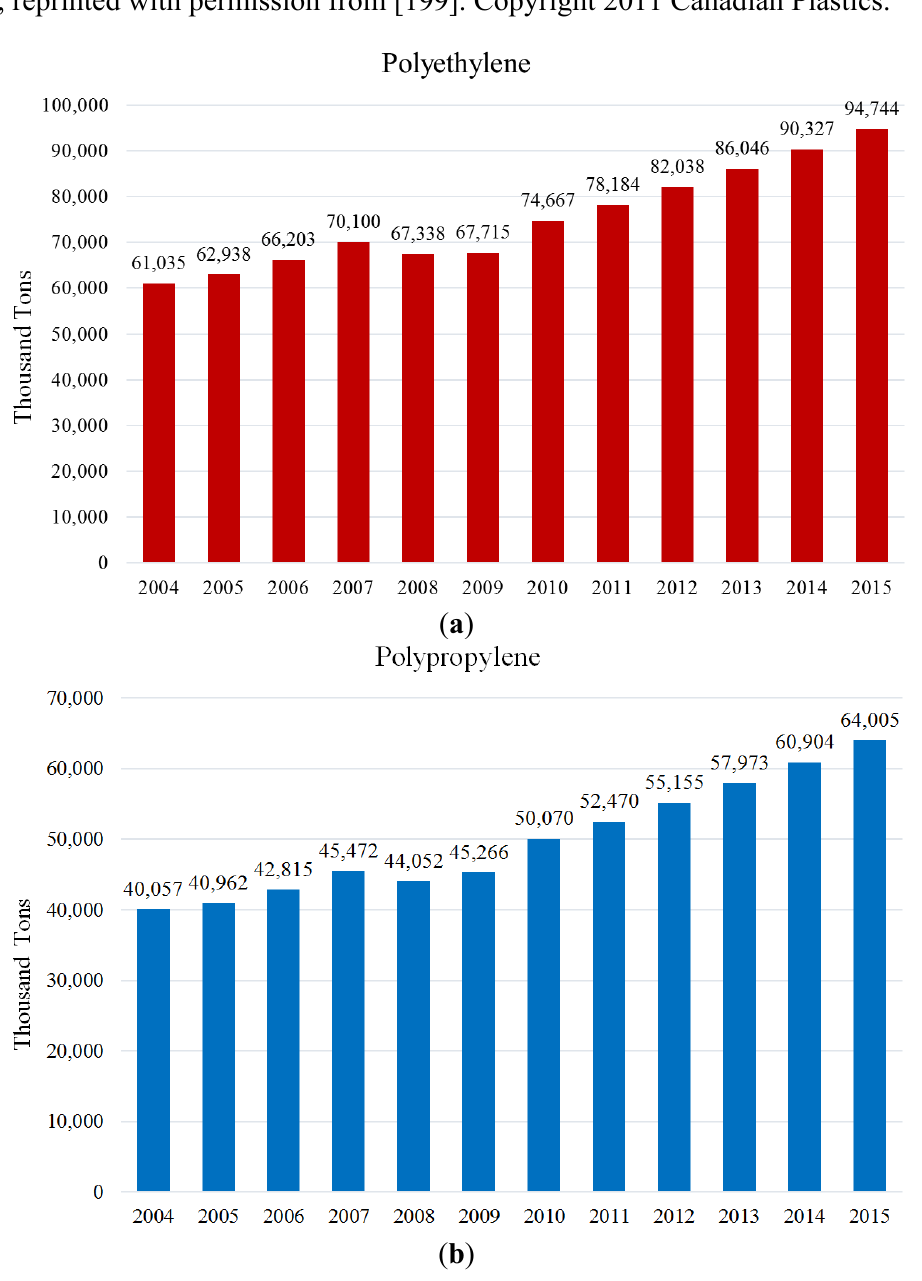
Figure 9. Bar chart representation of the world’s demand for PE ( a ); and PP ( b ) from 2004 to 2015, reprinted with permission from [199]. Copyright 2011 Canadian